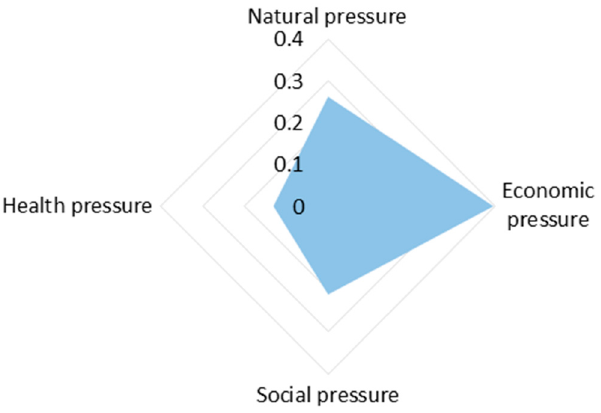
Figure 2. Comprehensive index of livelihood pressure of rural households in earthquake-stricken areas.